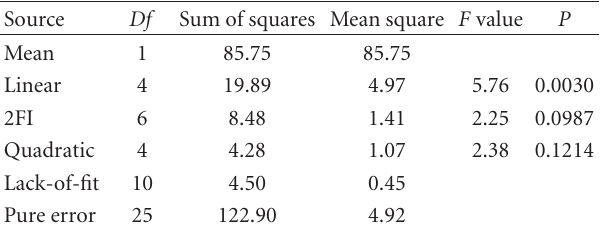
Table 4: Analysis of variance, showing the e ff ect of the variables as linear, square and interactions on the response OOC% of HYOOA ( Y ) of the D-optimal design.